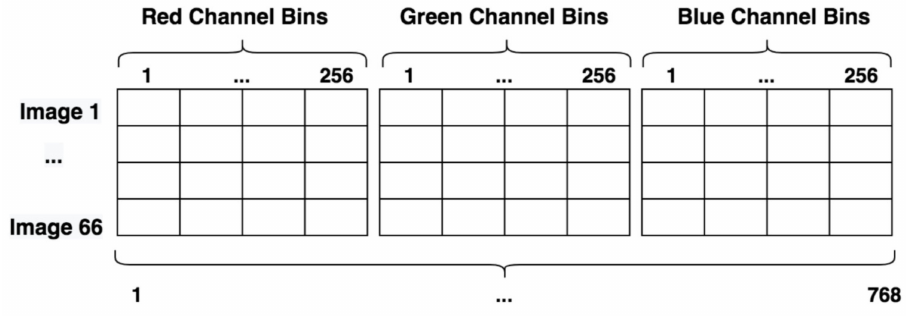
Figure 5. Concatenated RGB space